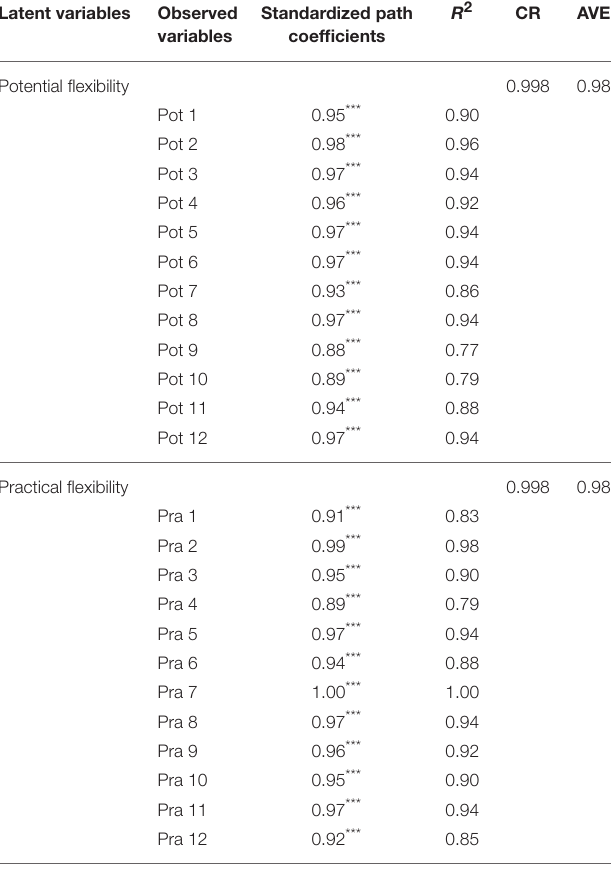
TABLE 5 | Composite reliability and convergent validity of potential flexibility and practical flexibility ( N = 158). Latent